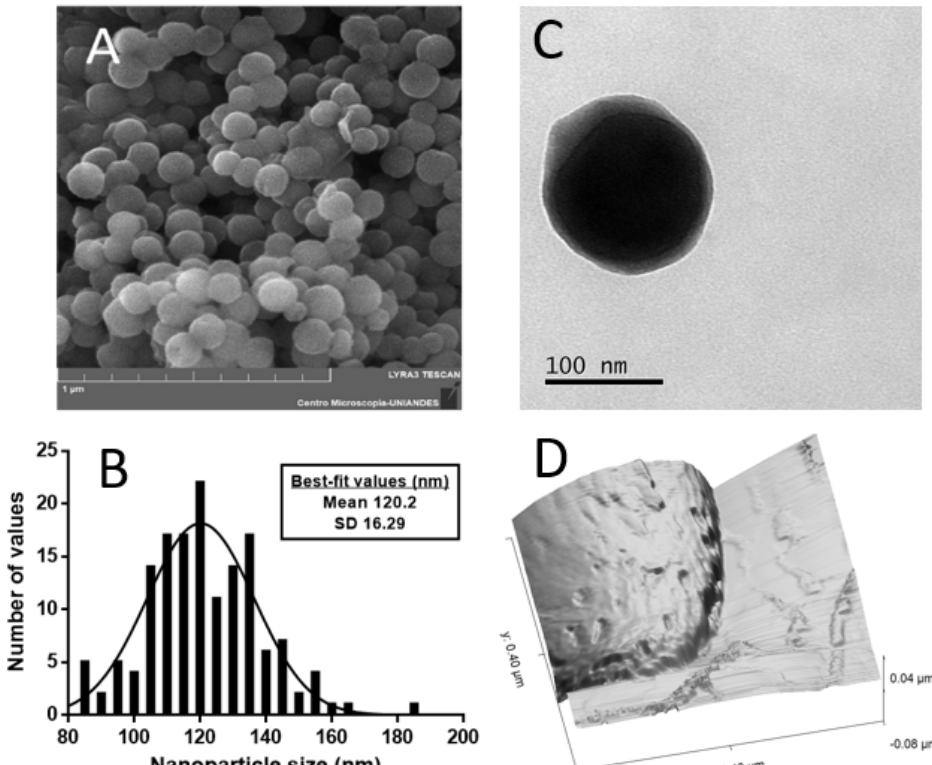
Figure 1. ( A ) SEM image of L-NPs synthesized via sol-gel template-based chemistry; ( B ) nanoparticle diameter histogram for a representative sample and the best fit values for a normal distribution; ( C ) TEM image of a single E-NPs showing the core-shell structure; ( D ) AFM image of E-NPs showing the presence of nanopores in the surface.